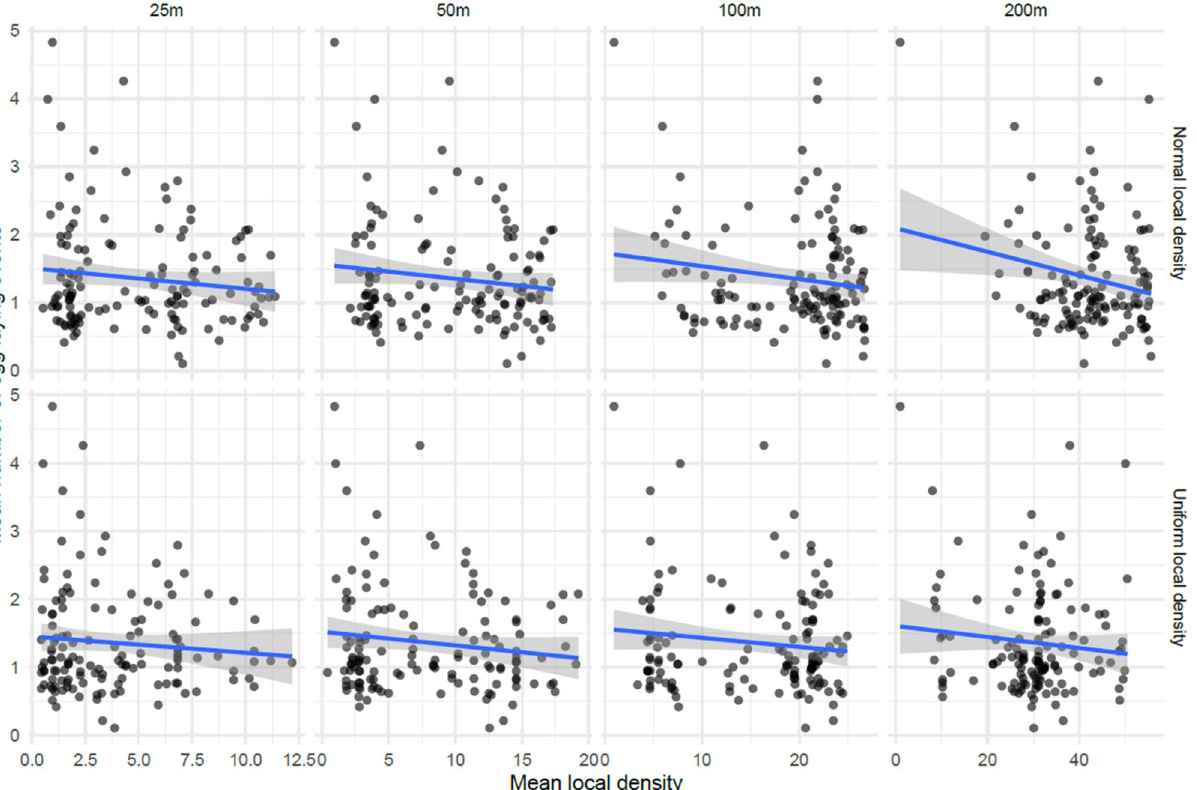
Figure 7. Mean Number of inferred egg laying events and the mean local density of ovitraps in the previous week over the course of the study. This plot shows the mean number of inferred egg laying events by the mean local density of ovitraps in the previous week for all ovitraps. The rows correspond to the Normal and Uniform local density models and the columns give the distance parameter for those models. The x-axis can be loosely interpreted as the number of other ovitraps that are within about the specified number of meters of the given ovitrap. The blue line shows the predicted mean of the linear model of the